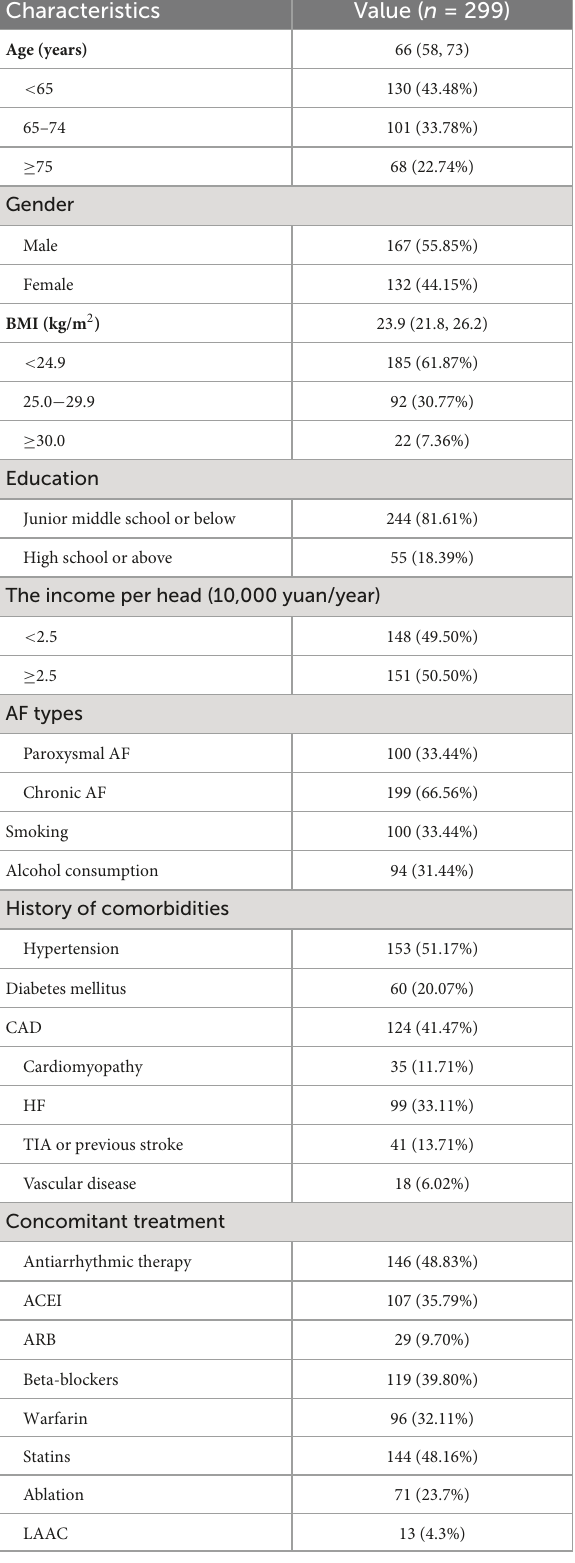
TABLE 1 Demographic and clinical data of atrial fibrillation patients at baseline.